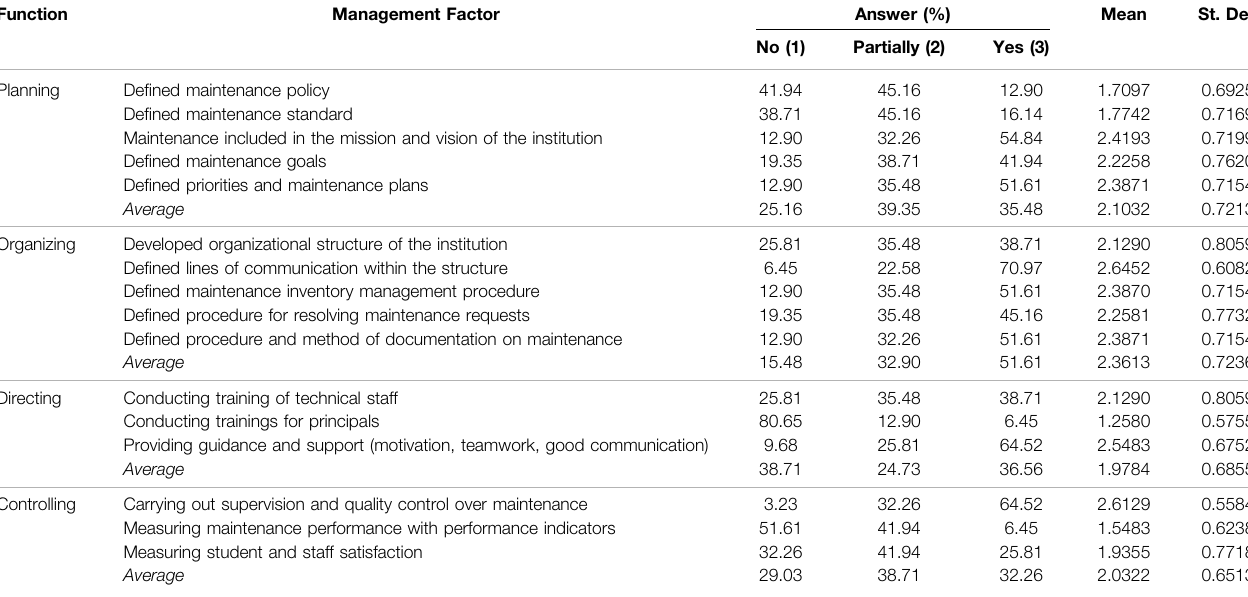
TABLE 3 | Are individual maintenance management factors implemented in the current school maintenance management process?